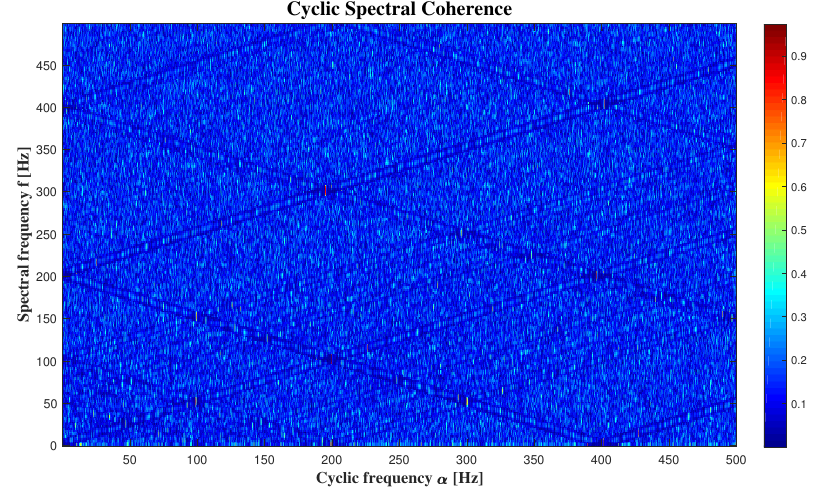
Figure 8. The cyclic spectral coherence.